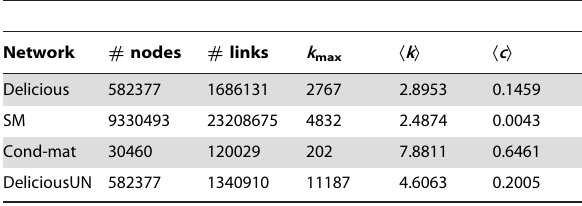
Table 1. Basic statistical features of Delicious, SM and Cond- mat networks.